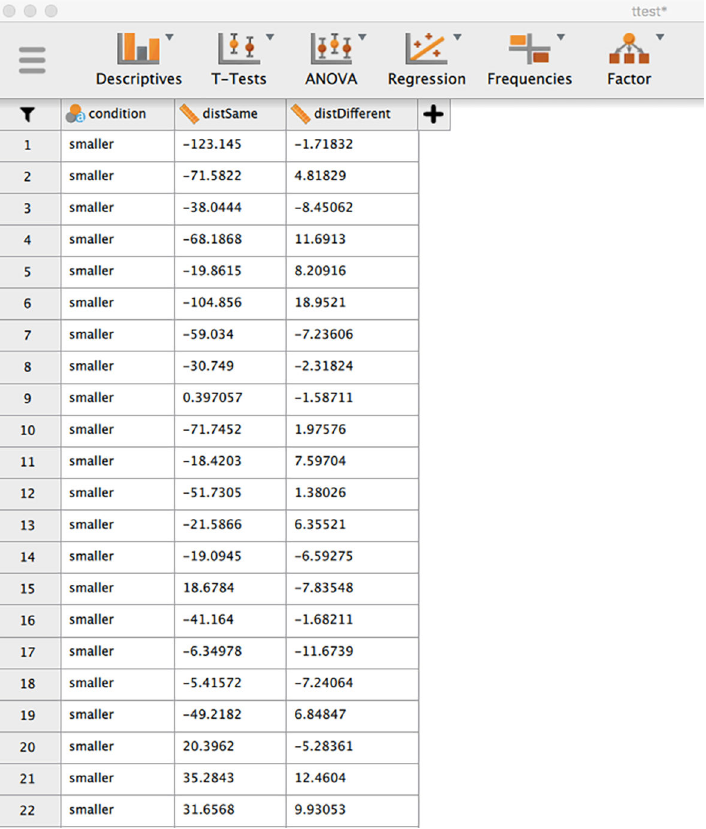
Figure 1. JASP screenshot showing the ttest.csv data set, modeled after Verguts and De Moor (2005).